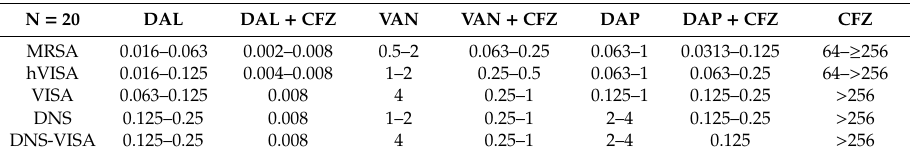
Table 1. Summary of MIC values of DAL, VAN, and DAP alone and in combination with CFZ utilizing the Broth Micro-dilution Method (mg /